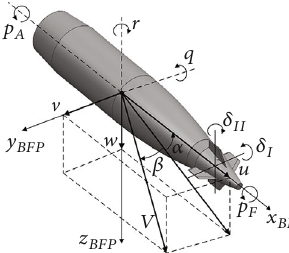
Figure 1: Concept of the dual-spin